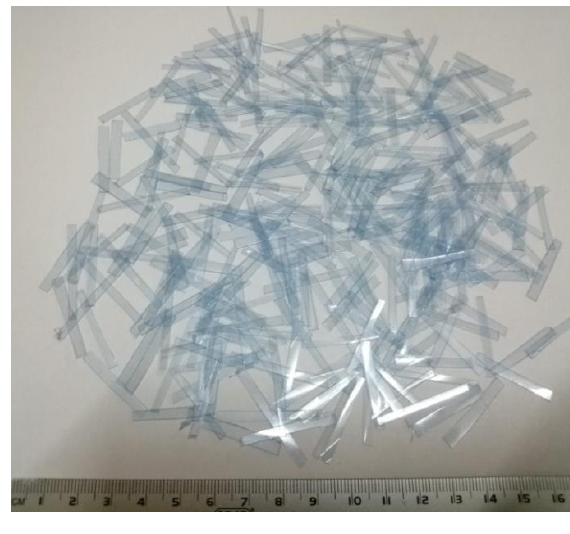
Figure 2. Fibers obtained from the shredded plastic bottles.